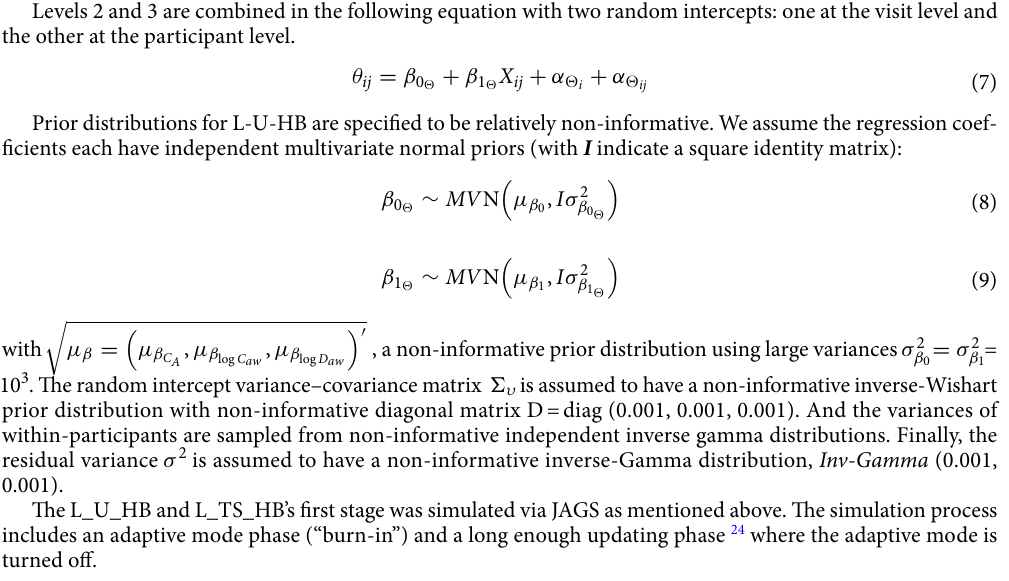
Population-level (across-participant) Within-participant (across-visit) Mean ( µ ) Standard Deviation ( τ ) Standard Deviation ( σ ) Correlation ( ρ NO parameter